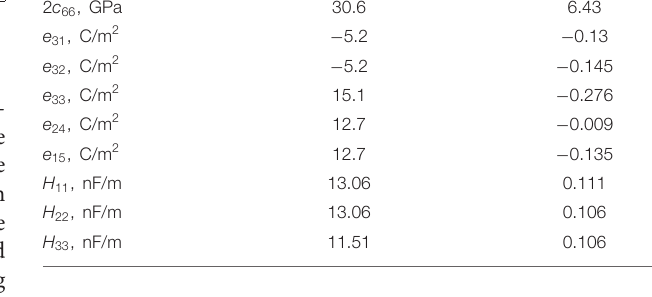
FIGURE 1 | The 3D geometry of the piezoelectric laminated plate represented in the plane ( x 1 , x 3 ).